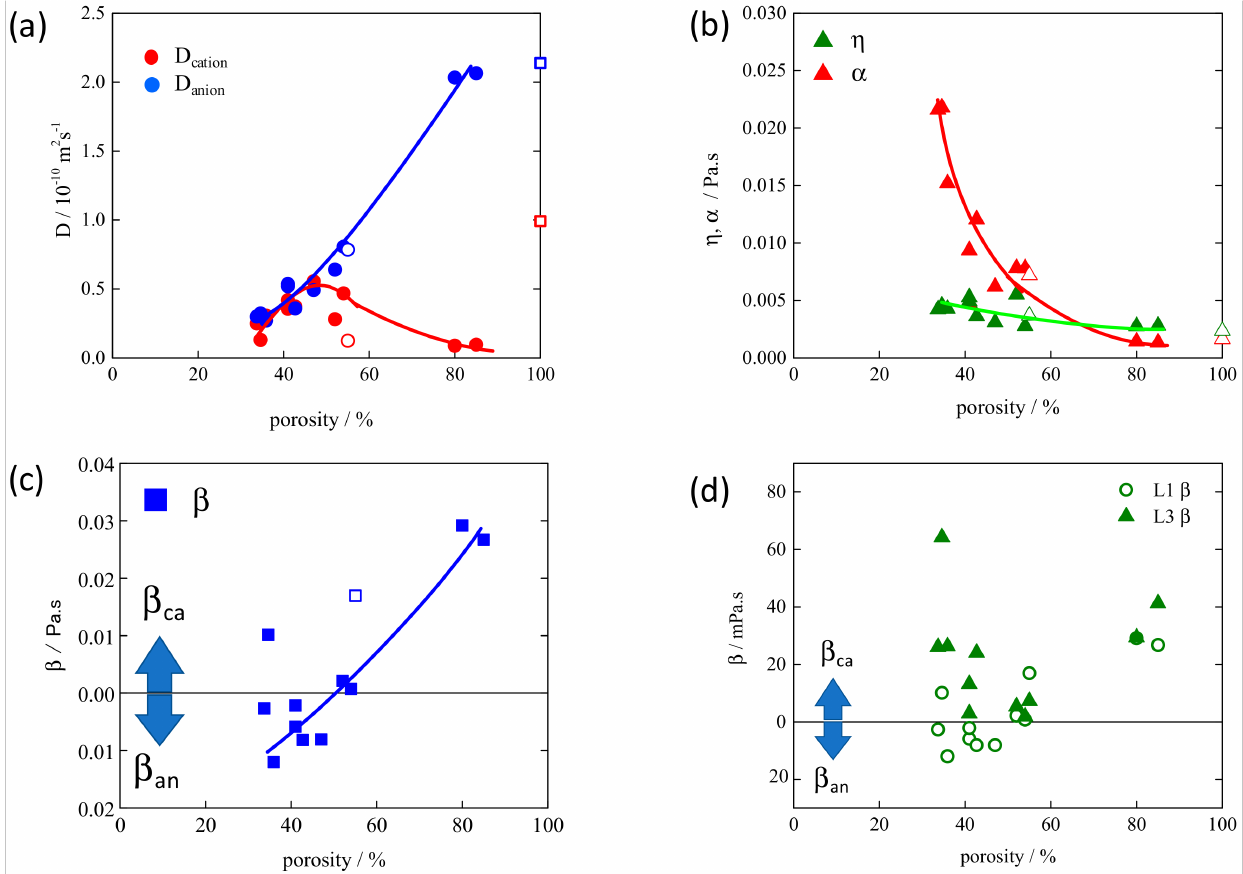
Figure 5. Estimated dynamic values: ( a ) D cation , D anion ( b ) η , α ( c ) β cation , β anion of L1 solution in separator membranes, and ( d ) comparison of β cation , β anion between L1 and L3 as a function of porosity of the membrane. Hallow marks at 55% represent the polypropylene (PP) membrane and at 100% represent the free electrolyte solution. Reprinted with permission from [24,30]. Copyright 2017, 2018 ACS